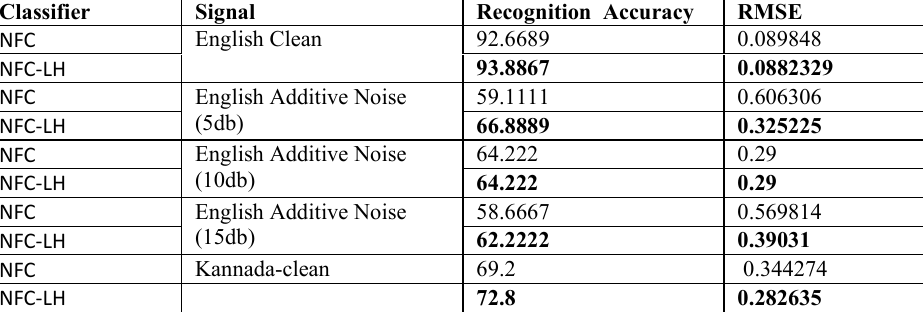
Table 3. Recognition accuracy for clean and Noisy speech signals for NFC and NFC-LH classifier